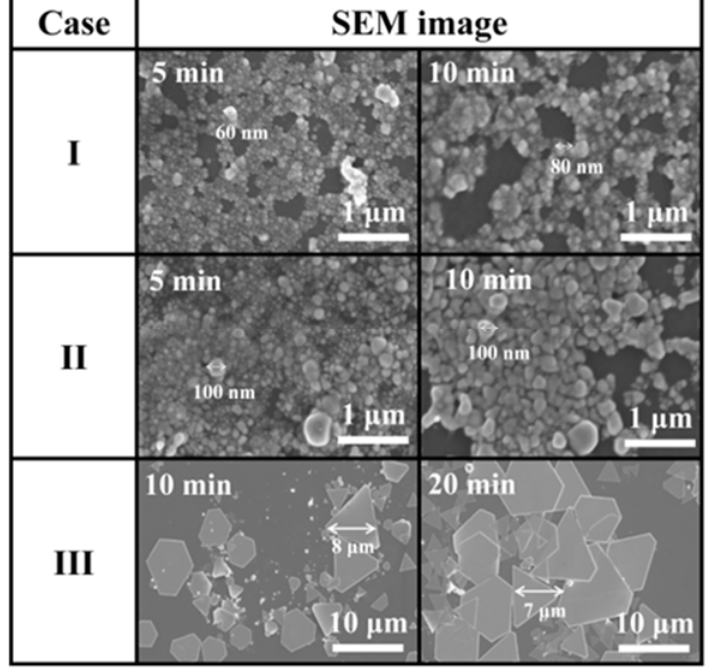
Figure 5. Scanning electron spectroscopy (SEM) images of synthesized Ag nanoparticles (NPs) through solution plasma process (or liquid plasma process) SPP (or LPP) for three cases.